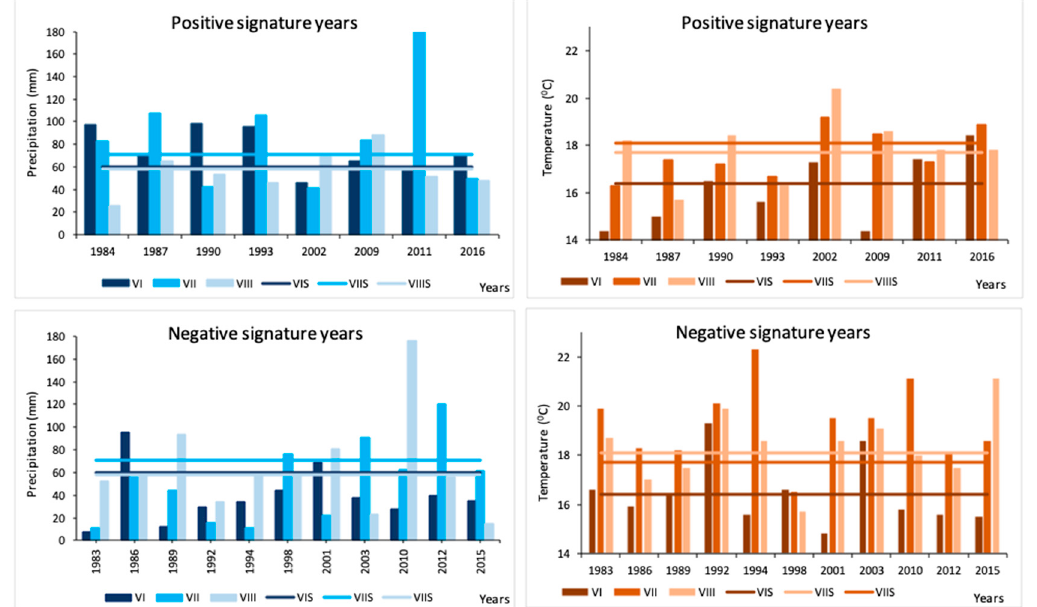
Figure 5. Precipitation in June, July and August (blue bars) in positive and negative signature years in comparison to the average precipitation in June, July and August of the years 1948–2020 (blue lines). Temperature in June, July and August (orange bars) in positive and negative signature years in comparison to the average temperature in June, July and August of the years 1948–2020 (orange lines).